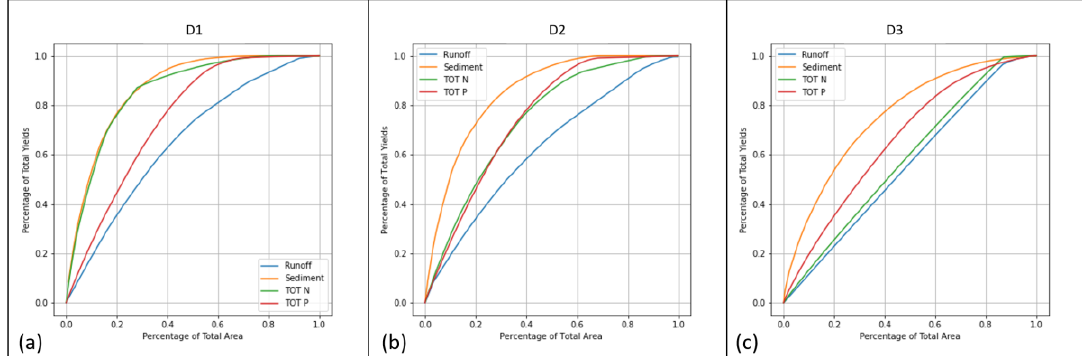
Figure 8. Mass-area ratios of surface runoff (SurfQ), total sediment (Sed), total nitrogen (Tot N), and total phosphorus (Tot P) in three synthetic watersheds: ( a ) synthetic natural watershed (D1), ( b ) synthetic agricultural watershed (D2), ( c ) synthetic urban watershed (D3).